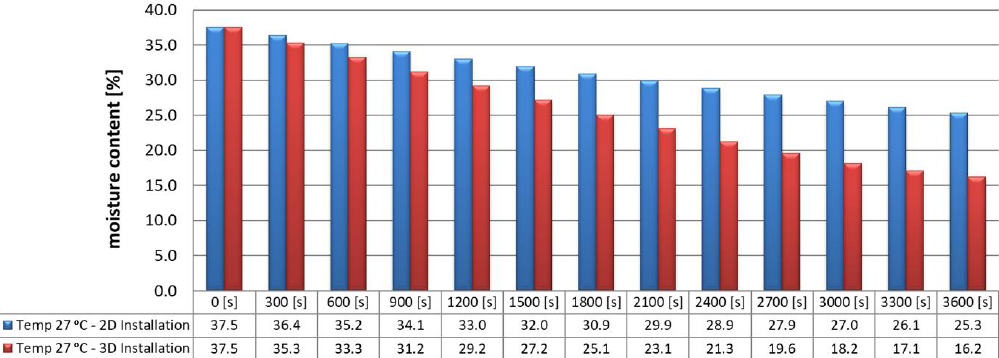
Figure 12. Influence of air temperature on the drying process in the 3D installation. Grain size was 0– 8 mm of Turów lignite.